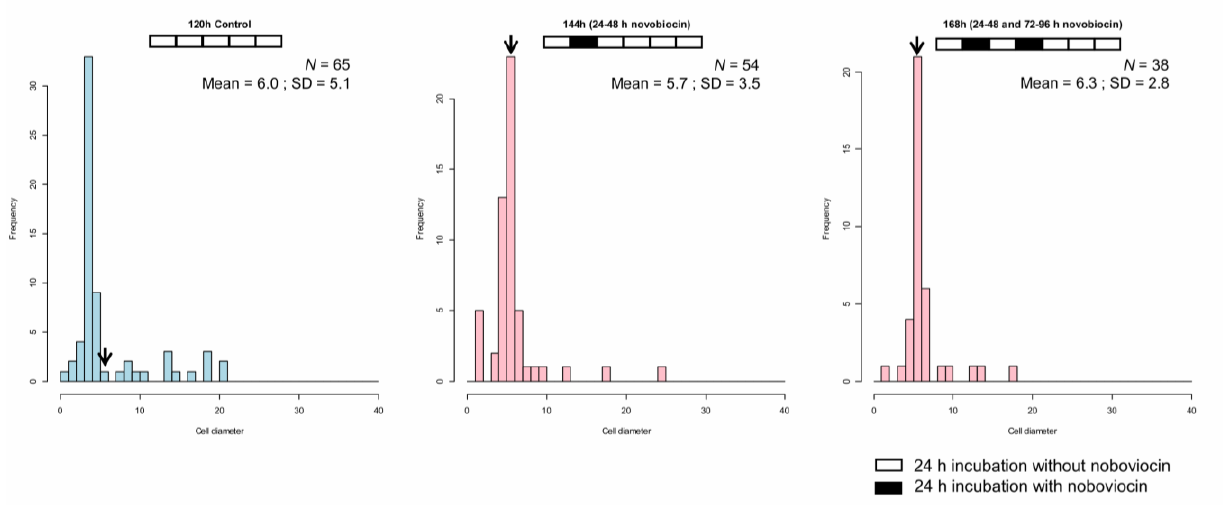
FIGURE 5: Cell size distribution of E. faecalis protoplast cells treated twice with novobiocin. The arrows indicate the fraction of cells with a diameter between 5 and 6